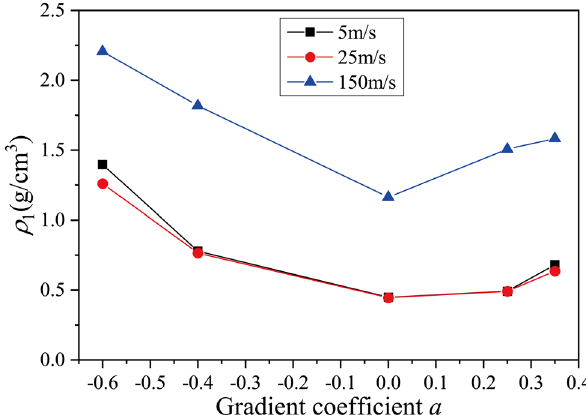
Figure 10: Density of the dense area swept by shock wave ρ 1